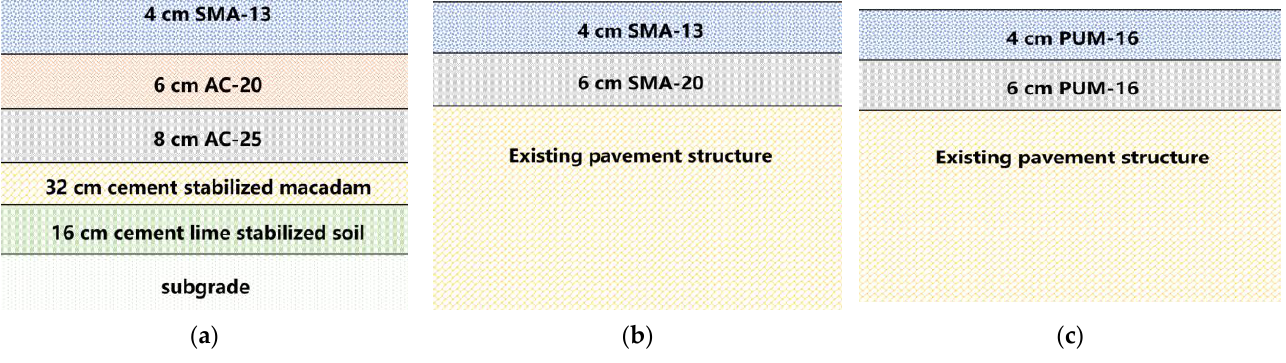
Figure 4. Composite pavement structure. ( a ) Old pavement structure; ( b ) Main line pavement structure; ( c ) Polyurethane mixture pavement structure.